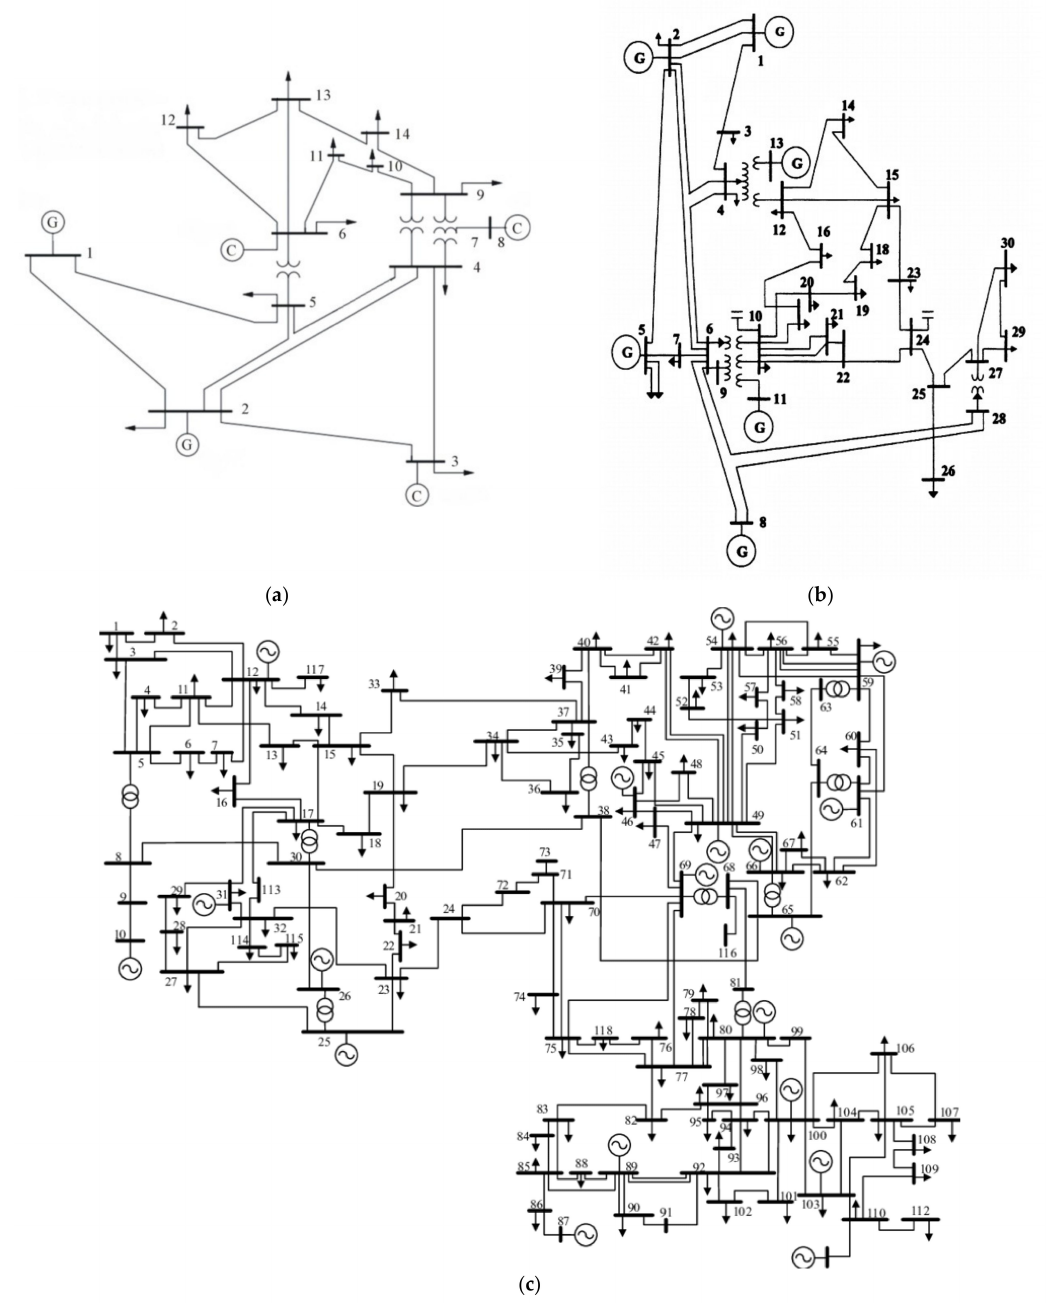
Figure 3. Configuration of IEEE ( a ) 14 bus system; ( b ) 30 bus system; and ( c ) 118 bus